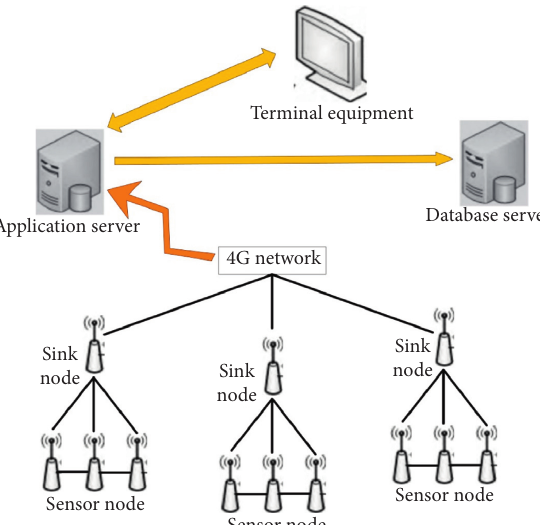
Figure 1: Overall system structure